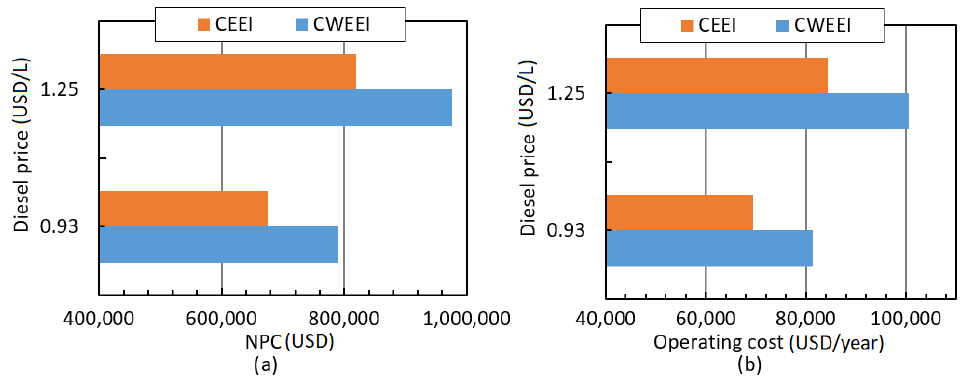
Figure 5. Costs of the CEEI and the CWEEI for stand-alone diesel generator configuration, ( a ) NPCs, y ( b ) Operating costs.